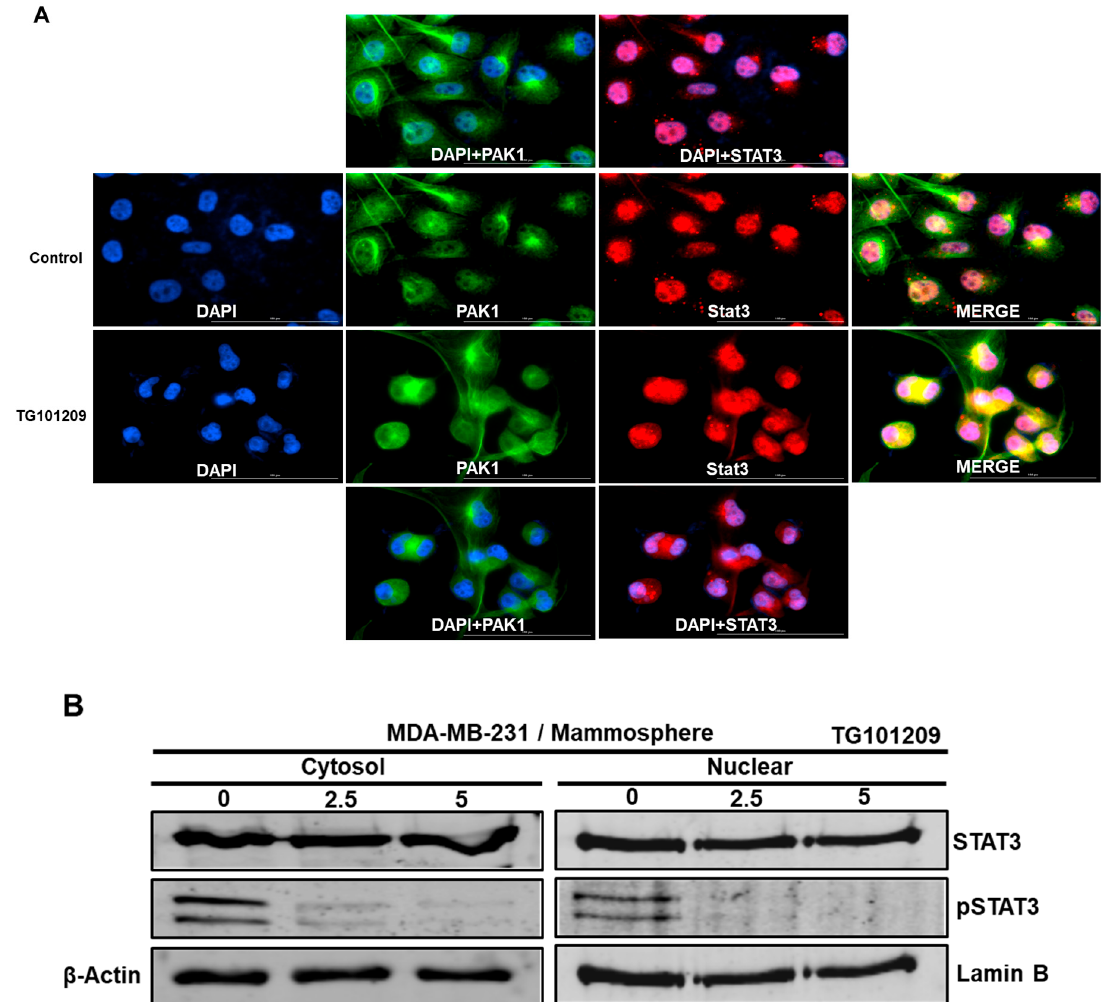
Figure 6. Effect of a JAK2 inhibitor on nuclear PAK1 and Stat3 levels and on the colocalization of PAK1 and Stat3. ( A ) Immunofluorescence analysis of PAK1 (green) and Stat3 (red) expression in breast cancer cells using anti-PAK1 and anti-Stat3 antibodies after TG101209 treatment. Images were captured by microscopy at 10 × magnification. ( B ) E ff ect of TG101209 on cytosolic and nuclear pStat3 protein levels.